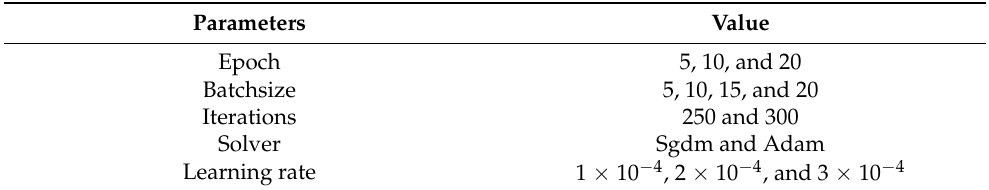
Sgdm: stochastic gradient descent with momentum; Adam: adaptive moment